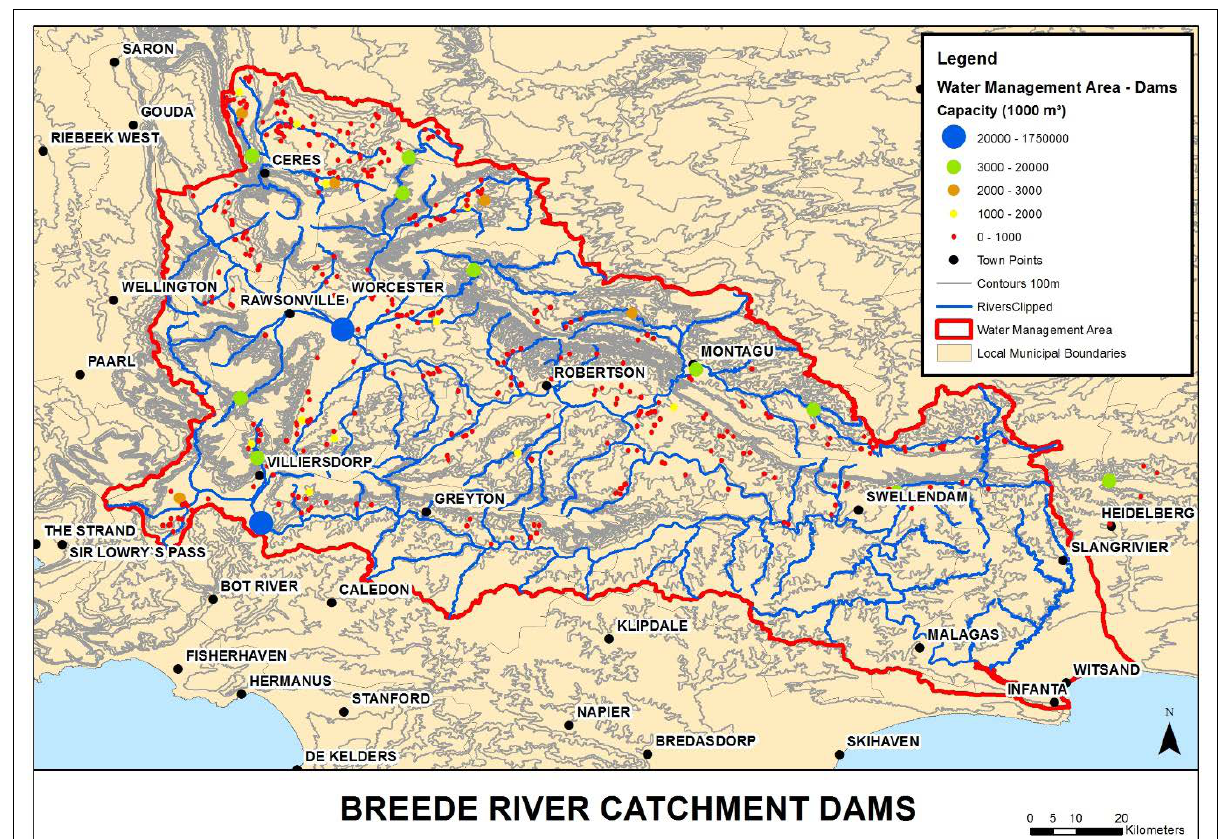
figure 1: Map of the Breede River